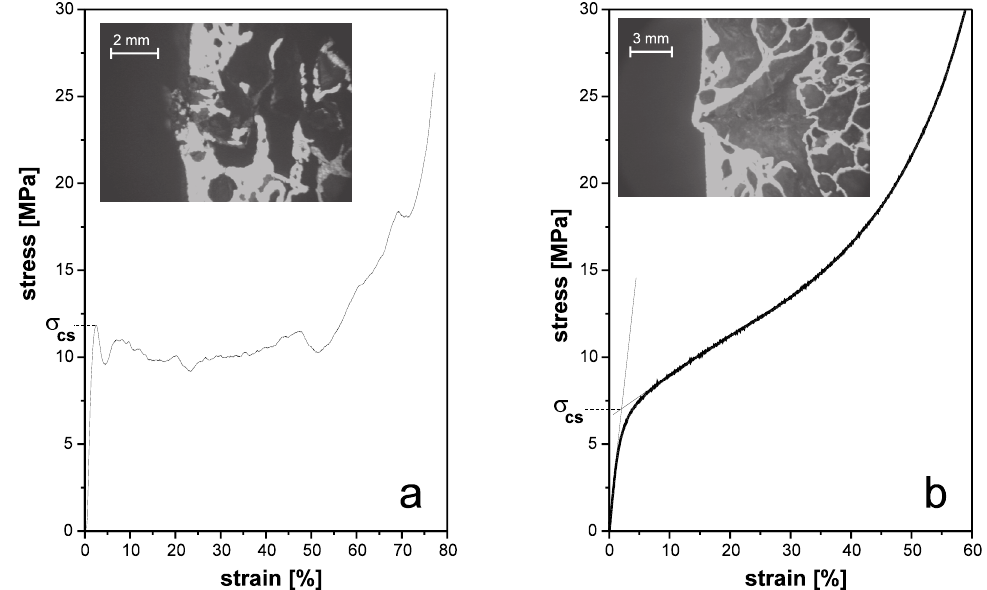
Figure 1: Typical stress-strain curves for, the definition of the compression strength of and the macroscopic structural changes at compression strength for: (a) brittle AlSi11Mg0.6 foam, 0.18 volume fraction of metal, (b) ductile Al 99.96 foam, 0.31 volume fraction of metal.